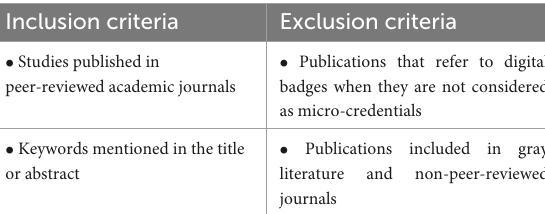
TABLE 1 Inclusion and exclusion criteria used for screening. TABLE 2 Distribution of articles included in the data extraction process per